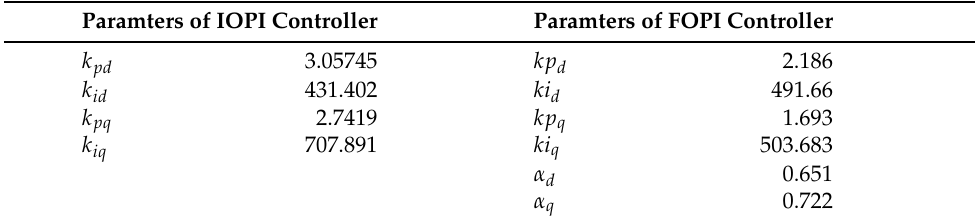
Table 2. The parameter iteration result.